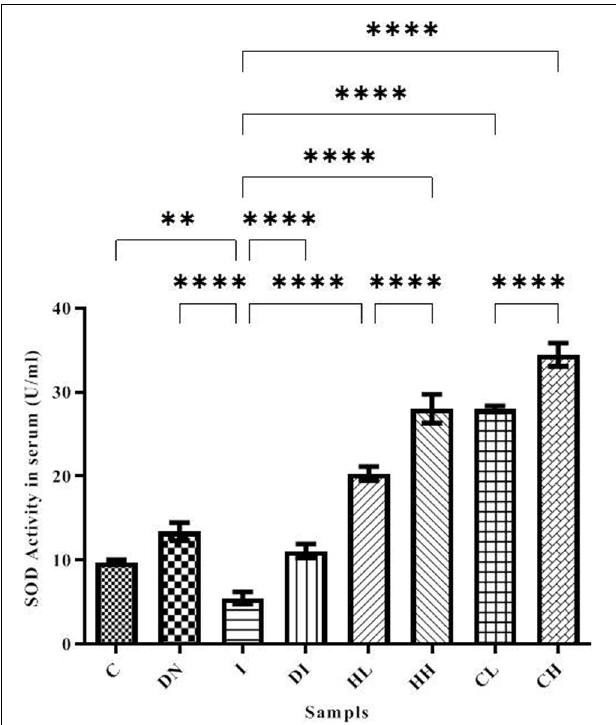
FIGURE 3 | SOD activity in the serum of the treated mice, Group C, control group: Normal saline-receiving group; Group DN, normal saline and deferoxamine-receiving group; Group I, iron dextran and normal saline-receiving group; Group DI, iron dextran and deferoxamine-receiving group; Group HL, low dose hesperidin-receiving group; Group HH, high dose hesperidin-receiving group; Group CL, low dose coumarin-receiving group; and Group CH, high dose coumarin-receiving group (Mean ± SD; ∗∗ p ≤ 0.01, ∗∗∗∗ p ≤ 0.0001).